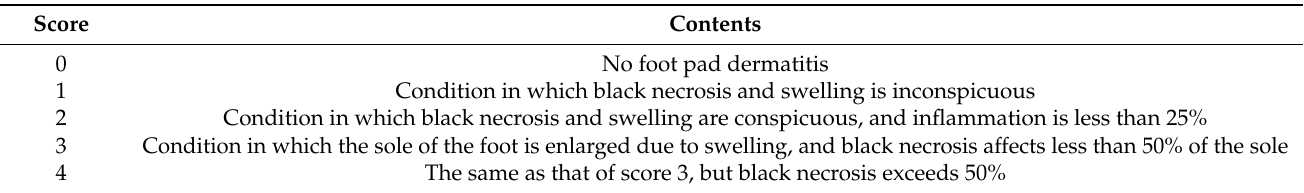
Table 1. Footpad dermatitis score indicative of